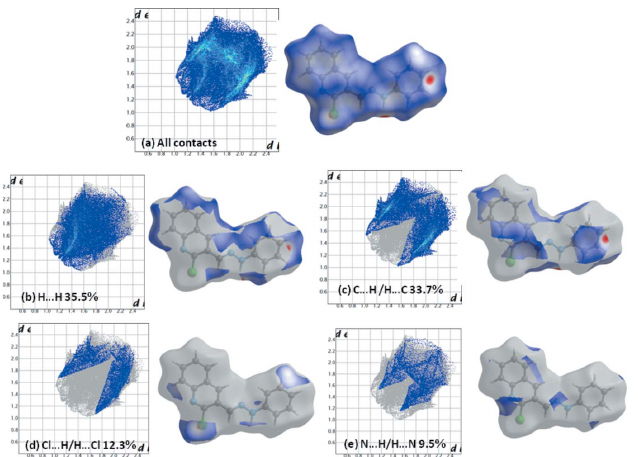
Figure 6 The overall two-dimensional fingerprint plot for compound 5 , and those delineated into: ( b ) H (cid:2)(cid:2)(cid:2) H (35.5%), ( c ) C (cid:2)(cid:2)(cid:2) H/H (cid:2)(cid:2)(cid:2) C (33.7%), ( d ) Cl (cid:2)(cid:2)(cid:2) H/H. (cid:2) Cl (12.3%) and ( e ) N (cid:2)(cid:2)(cid:2) H/H (cid:2)(cid:2)(cid:2) N (9.5%) contacts.